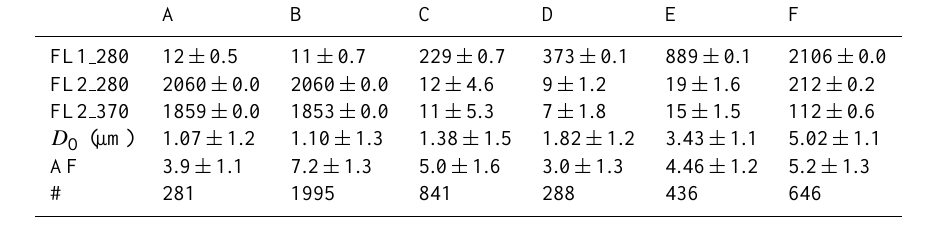
Fig. 4. PSL cluster analysis statistics. The 13 cluster solution was chosen due to the concomittant drop in R 2 and N , and the rise in RMS.